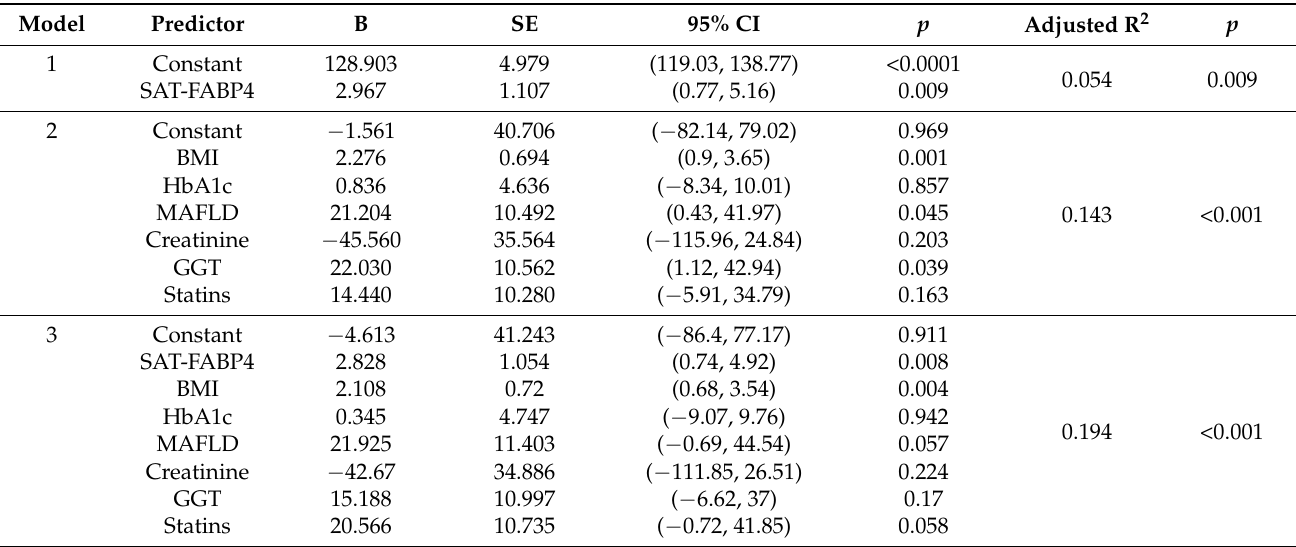
Table 4. Summary of hierarchical regression analysis for variables predicting circulating TG levels in subjects with obesity.